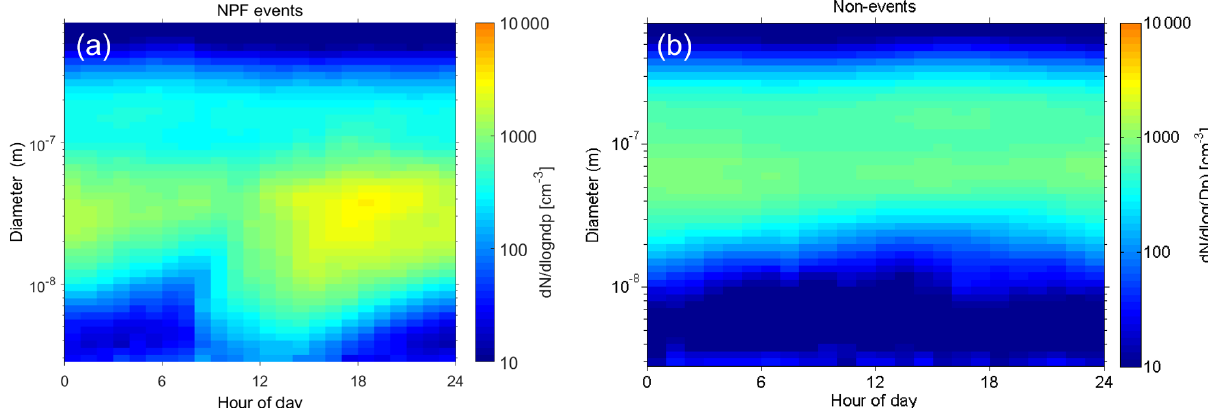
Figure 6. The median number size distribution of all observed NPF events ( n = 33) and non-events ( n = 75) during our measurement period. The data were collected with a DMPS, and size bins from 2.82 to 708nm are plotted.